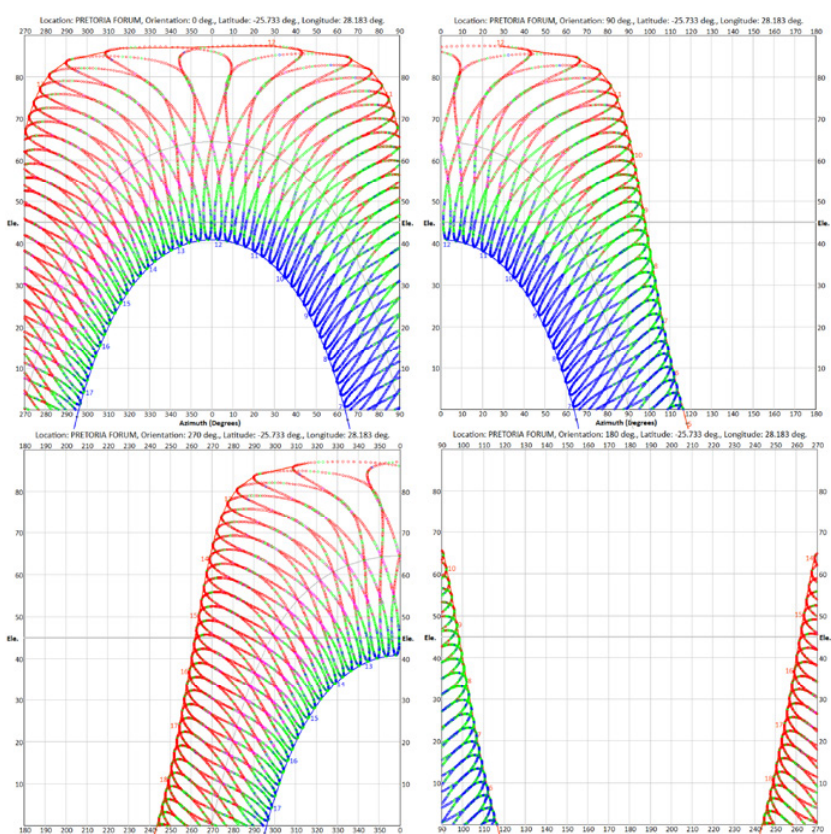
Figure 8: Annual solar charts for central Pretoria that indicate the temperature radiation profile for 0 ° (top left), 90° (top right), 180° (bottom right) and 270° (bottom left) orientations (all angles are measured clockwise from north). The horizontal axis is the solar azimuth (horizontal angle in clockwise degrees from north) and the vertical axis the solar elevation in degrees above the